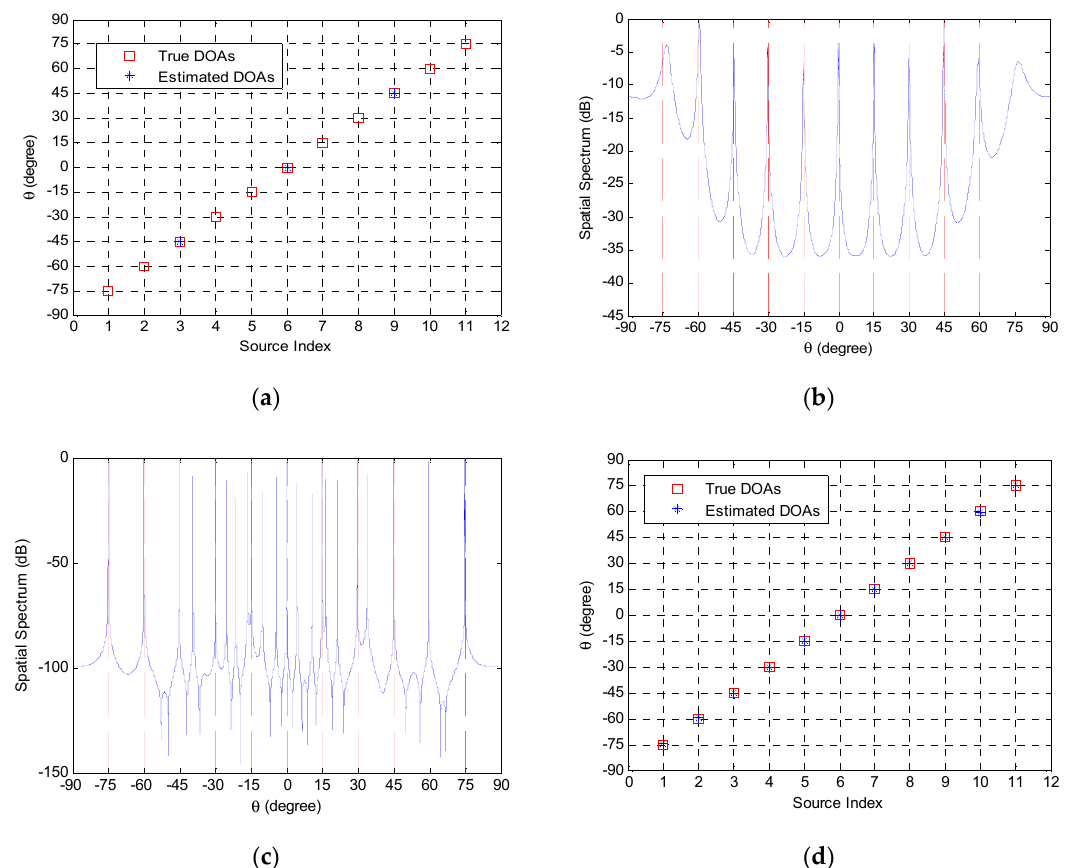
Figure 2. The resolution performance of each method with coprime array when the number of sources is larger than that of physical sensors: ( a ) the partial spectral search method; ( b ) the coprime MUSIC method; ( c ) the sparsity-based method; ( d ) the proposed method; first example.